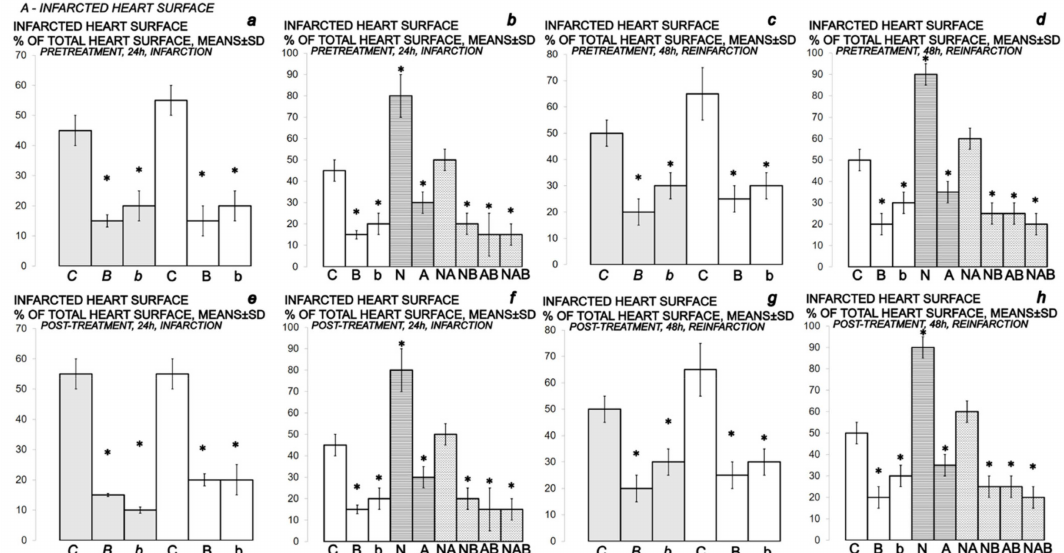
Figure 12. Myocardial infarction (one isoprenaline challenge) and re-infarction (two isoprenaline subsequent challenges) in isoprenaline-rats (75 mg/kg sc (gray bars), 150 mg/kg sc (white bars)), gross heart lesions presentation, A- INFARCTED HEART SURFACE . Isoprenaline-rats treated with the smaller dose, 75 mg/kg sc (gray bars, italic letters), received medication (BPC 157 (10 ng/kg ( b ), 10 µ g/kg ( B ) i.p. or saline (5 mL/kg i.p. ( C )). Isoprenaline-rats treated with the higher dose, 150 mg/kg sc (white bars, normal letters), received medication (BPC 157 (10 ng/kg (b), 10 µ g/kg (B) i.p. or saline (5 mL/kg i.p. (C)) or L-NAME (5 mg/kg i.p. (N)), L-arginine (200 mg/kg i.p. (A)) (horizontal line bars) or these agents in combination (L-NAME + L-arginine (NA), L-NAME + BPC 157 (NB), L-arginine + BPC 157 (AB), L-NAME + L-arginine + BPC 157 (NAB)) (dashed horizontal lines bars). Therapy was given (i) 30 min before isoprenaline ( PRETREATMENT , prophylactic regimen ( a – d )), or, alternatively, (ii) at 5 min after isoprenaline (75 mg/kg s.c. or 150 mg/kg s.c.), at day 1 and at day 2 ( POST-TREATMENT , therapeutic regimen ( e – h )). Ten rats per each experimental group. * p < 0.05 vs. control, at least.